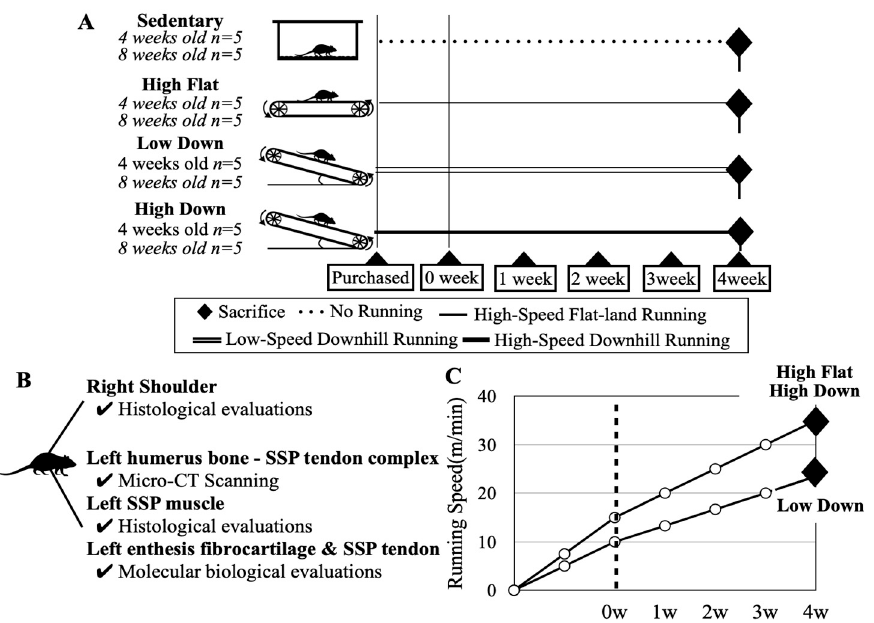
Figure 1. Schematic diagram showing target animals and exercise intervention methods. ( A ) Sche-matic diagram describing the grouping of target animals and the respective intervention methods and periods. Target mice were purchased at 3 and 7 weeks of age and the intervention was started at 4 and 8 weeks of age, respectively, to compare adolescent and adult mice. All mice were divided into four groups. After 1 week of environmental and exercise adaptation, the mice underwent a 4-week running intervention. Downhill running mimics the eccentric contraction of the supraspinatus muscle. ( B ) Tissues were collected from each mouse. ( C ) The running speed increased in step. The intervention speed did not change for mice of di ff erent ages.